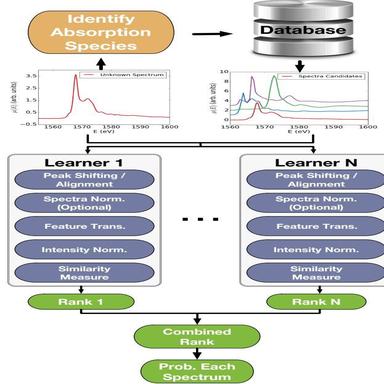
The Ensemble-Learned Spectra IdEntification (ELSIE) algorithm. In the first step, the absorption species is identified and used to narrow down the candidate computed reference spectra. In the second step, the spectral matching ensemble yields a rank-ordered list of computational spectra according to similarity with respect to the target spectrum. Reproduced with permission from Ref. .